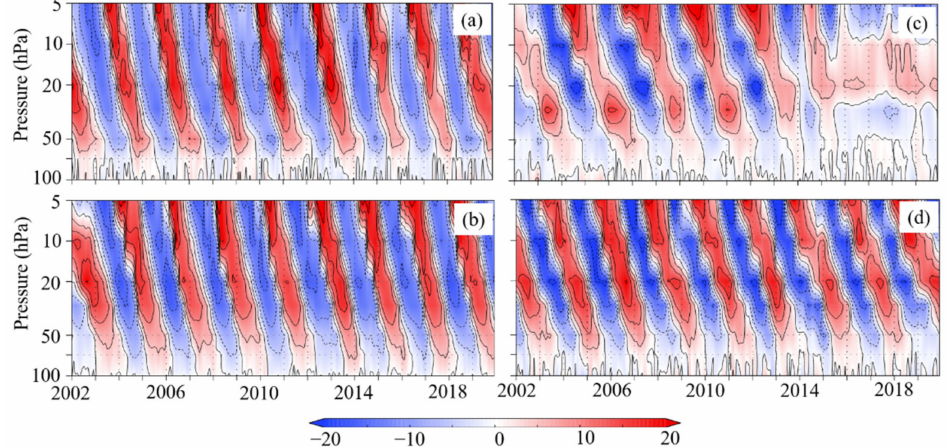
Figure 6. Power spectrum of zonal–mean-zonal wind from 100 hPa to 0.1 hPa averaged between 10 ◦ S and 10 ◦ N for the perpetual runs of ( a ) January, ( b ) July, ( c ) April, and ( d ) October. Values are displayed in a logarithmic scale of base 10 and units are in m 2 s − 2 . The contour interval is 0.4 m 2 s − 2 .